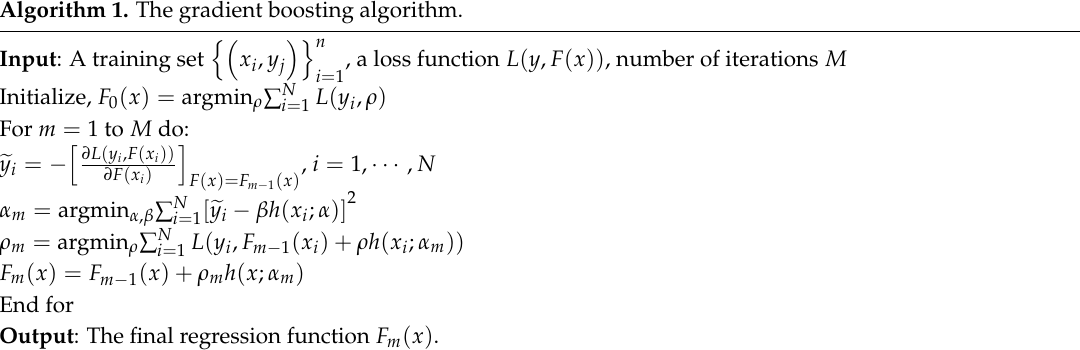
Algorithm 1. The gradient boosting